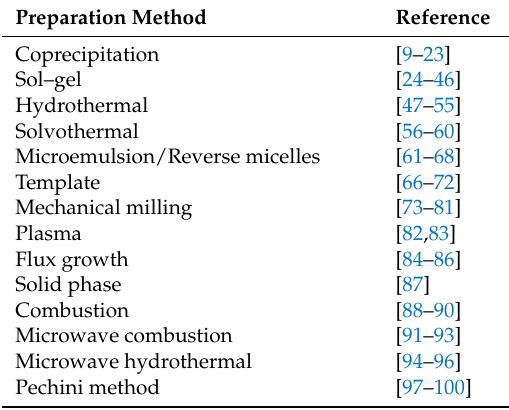
Table 1. Methods reported in the literature for spinel